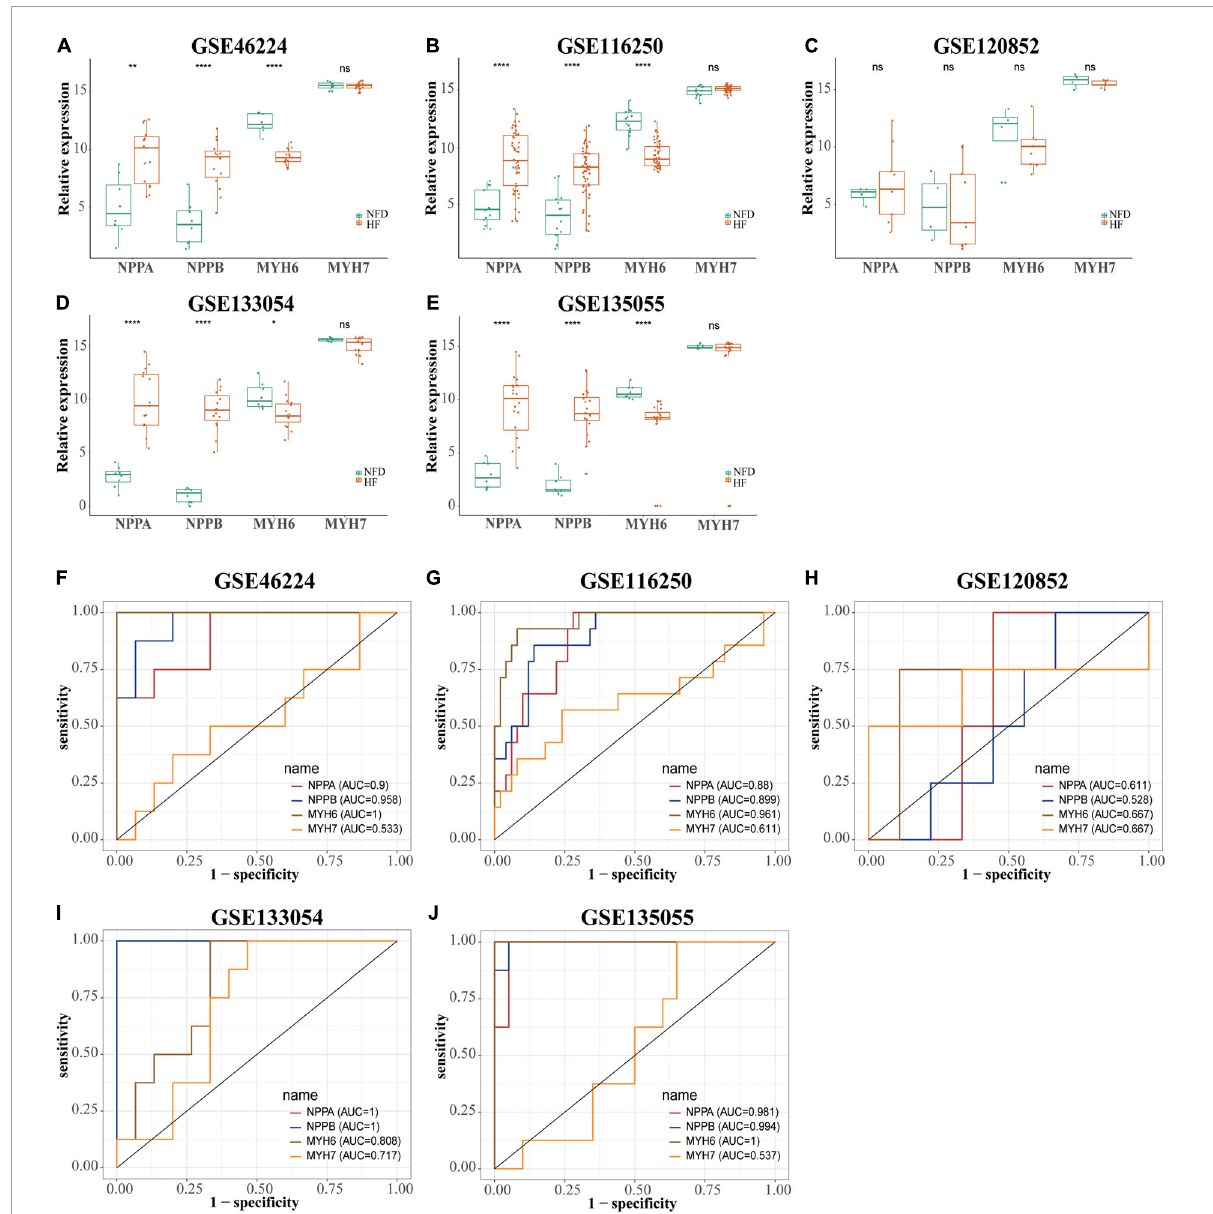
FIGURE4 Expression level and diagnostic value of NPPA , NPPB , MYH6 , and MYH7 in the five HF-related RNA-seq datasets. The expression level of NPPA , NPPB , MYH6 , and MYH7 in GSE46224 (A) , GSE116250 (B) , GSE120852 (C) , GSE133054 (D) , and GSE135055 (E) , respectively. ns, not significant vs. the NFD group; * p < 0.05 vs. the NFD group; ** p < 0.01 vs. the NFD group; **** p < 0.0001 vs. the NFD group. The diagnostic values of NPPA , NPPB , MYH6 , and MYH7 in GSE46224 (F) , GSE116250 (G) , GSE120852 (H) , GSE133054 (I) , and GSE135055 (J) , respectively, as determined by ROC curves. NPPA , natriuretic peptide A; NPPB , natriuretic peptide B; MYH6 , myosin heavy chain 6; MYH7 , myosin heavy chain 7; HF, heart failure; NFD, non-failing donor; ROC, receiver operating